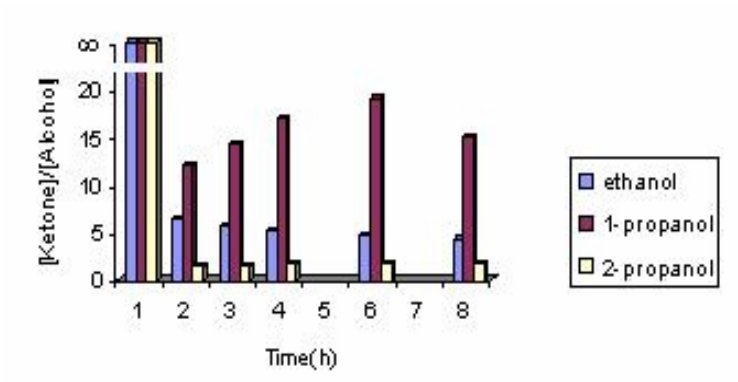
Figure 1 . Variation of the [acetophenone]/[1-phenylethanol] ratio